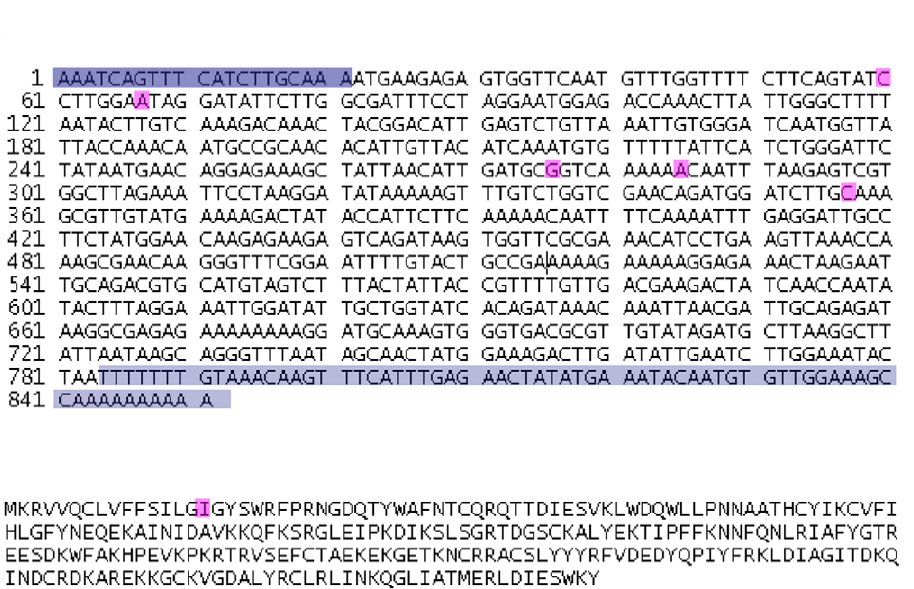
Figure 1. Sequences of the Tunisian Phlebotomuspapatasi 30 kDa salivary protein. ( A ) mRNA sequence of PpSP30. ( B ) Protein sequence of PpSP30. Differences in the nucleotide and protein sequence PpSP30 described in the GenBank (GenBank AF335489.1) are highlighted in pink. Non coding sequence is highlighted in purple.